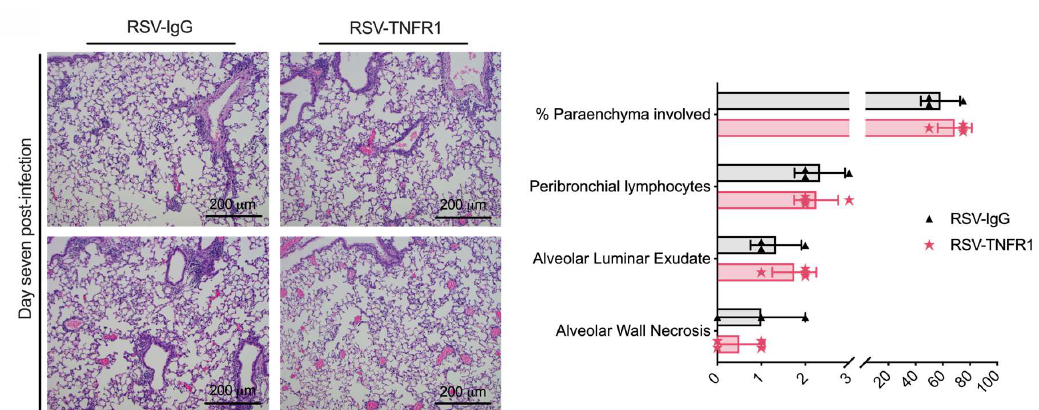
Figure 11. Post-infection blockade of TNFR1 does not improve lung pathology in RSV infections. Lung tissue was collected at (Left) day seven post-infection, imbedded in formalin for sectioning and slides were stained with H&E. Pathology scores shown to the right of the lung images. Data are expressed as mean ±